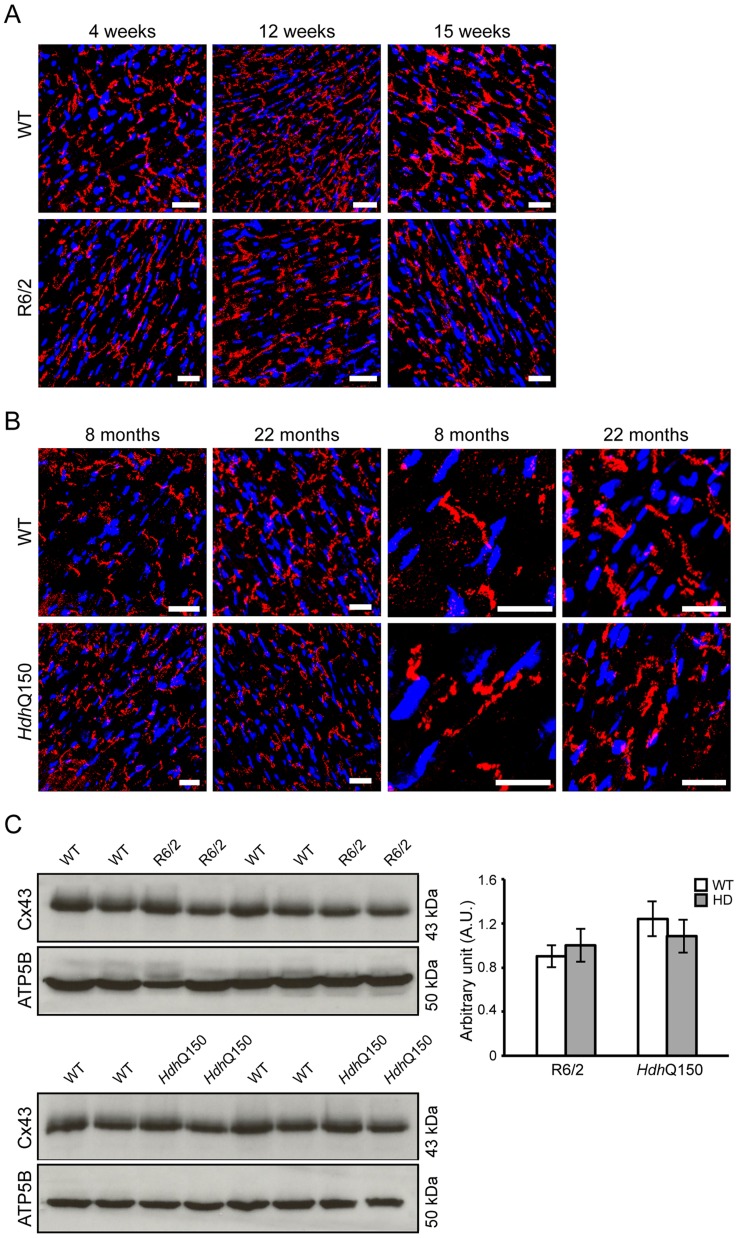
Altered connexin-43 localisation but not expression in the hearts of HD mouse models.Representative confocal pictograms of whole heart sections from (A) 4, 12 and 15 week old of R6/2 mice and (B) 8 and 22 month old HdhQ150 mice showing low and high magnification. Anti-Cx-43 antibody (red) and nuclei (blue) were visualised with DAPI. Scale bar 30 μm. (C) Western blots of Cx-43 in 14-week-old WT and R6/2 mice (top panel) and in 22-month-old WT and HdhQ150 mice (bottom panel). Relative expression of Cx-43 was normalized to ATP5b by densitometry and values are mean±SEM (n = 4). Student's t test: *p<0.05, **p<0.01, ***p<0.001.